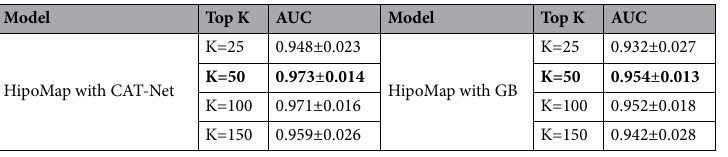
Table 2. Slide-based AUCs of the HipoMap with various top- K values on the validation data with the pretrained models of CAT-Net (left) and GB (right). The highest AUCs are highlighted in bold.